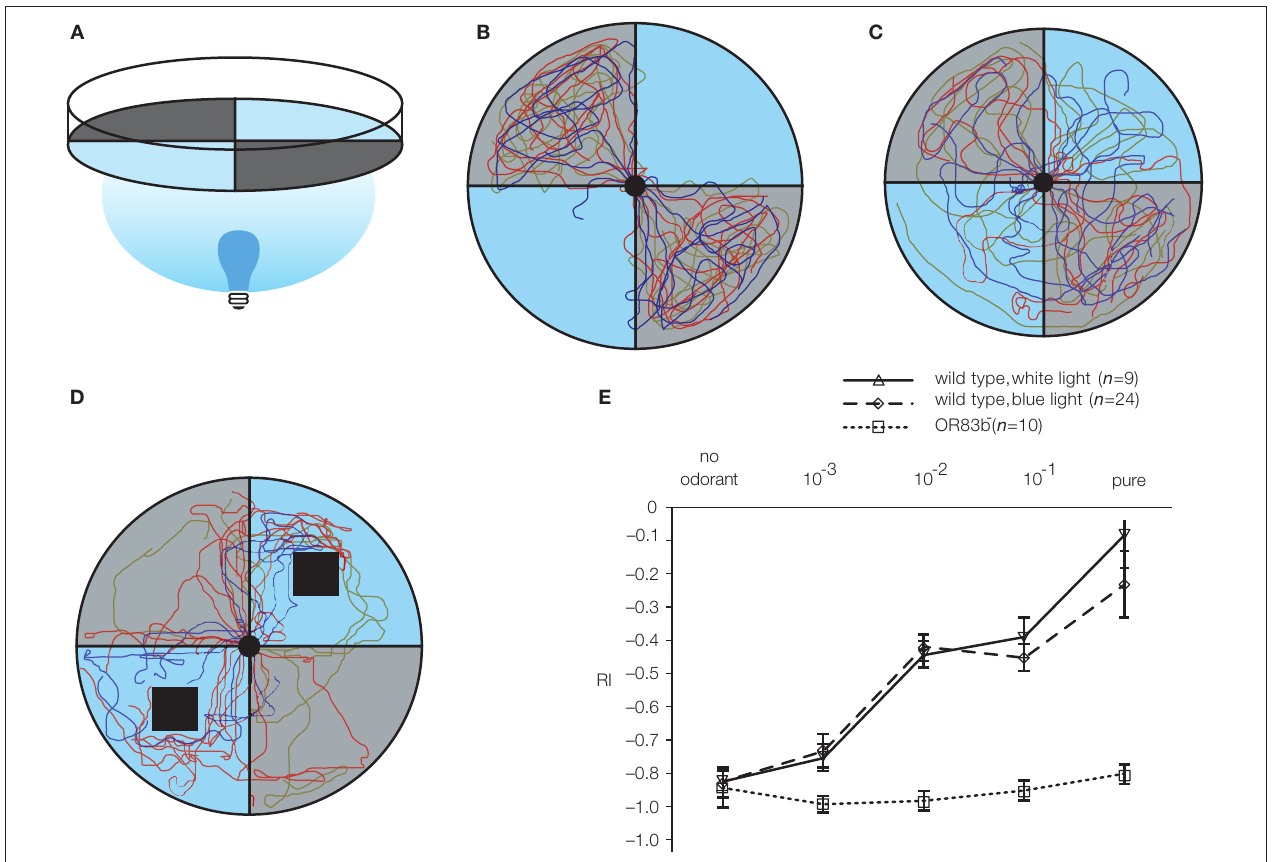
squares, show some attraction toward the odor source. (e) In a similar experimental setup a response index (RI) is calculated indicating the degree of attraction toward or repulsion from an odor source. A RI of − 1 indicates complete repulsion. In this experimental setup the repulsive odorant octyl acetate is applied in the dark quadrants at various concentrations. With increasing odor concentration wild type larvae escape from the dark into illuminated areas (blue or white light) as is indicated by the increasing RI. In contrast, anosmic mutants (Or83b − ) show a normal negative phototaxis behavior and strongly avoid blue or white light (modified from Bellmann et al.,